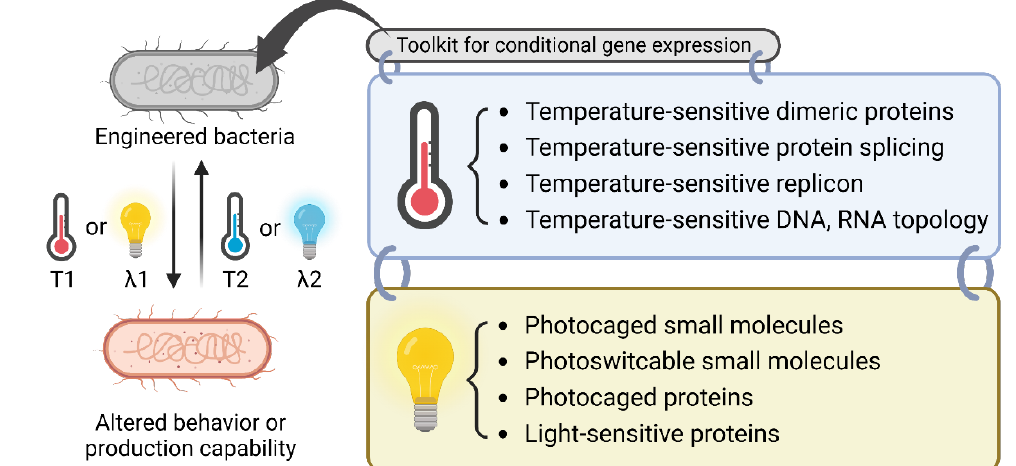
Figure 1. Overview of the molecular biology toolkit for conditional gene expression. A bacterium can be engineered to be sensitive to a temperature shift or specific light irradiation for the dynamic regulation of bacterial behavior or the production of chemicals or proteins. The toolkit for thermoregulation includes temperature-sensitive dimeric proteins, protein splicing, replicons, and oligonucleotide topology. For light-sensitive regulation, one can choose from the toolkit of photocaged small molecules, photoswitchable small molecules, photocaged proteins, and light-sensitive proteins. T1, T2: different temperatures; λ 1, λ2: different wavelengths .